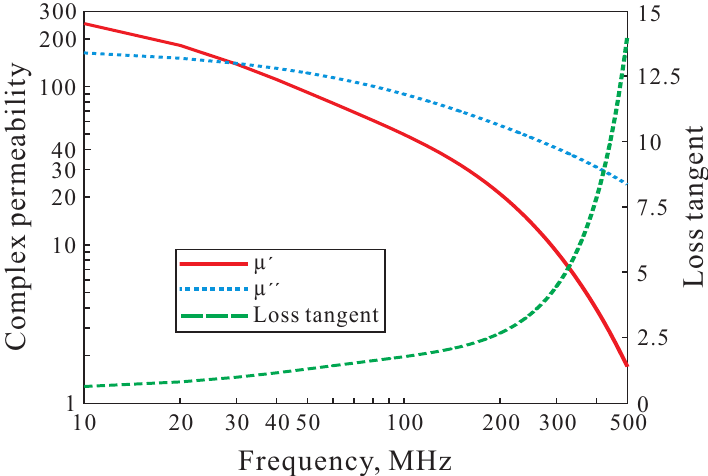
Figure 2. Complex permeability and magnetic loss tangent properties of the MP2106-0M0